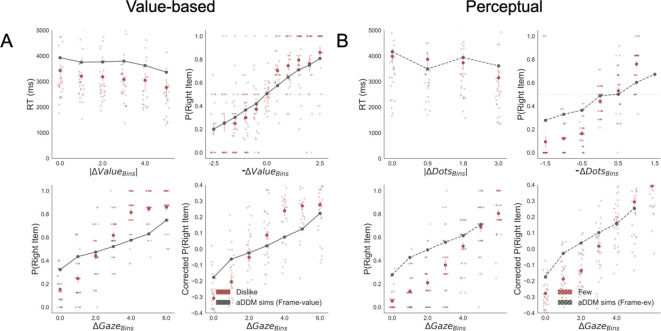
Replication of behavioural effects by aDDM simulations for dislike (A) and fewest (B) frames.Importantly, these models were fitted using goal-relevant evidence. The four panels present four relevant behavioural relationships found in the data. Top left: faster responses (shorter reaction time, RT) when the choice is easier (i.e. easier choices are found with higher |ΔValue| and |ΔDots| in Value and Perceptual Experiments, respectively). Top right: probability of choosing the right alternative increases when the evidence towards the left item is higher (-ΔValue and –ΔDots, that is, increment when left item is more valuable or has more dots than the right item). Bottom left: the probability of choosing the item on the right side of the screen depends on the gaze time difference (ΔGaze, calculated as the time observing the right minus the left item). Bottom right: gaze influence on choice depending on the difference in ΔGaze (check Results section for more details on gaze influence). Solid red dots depict the mean of the data across participants in dislike and fewest frames. Light red dots show the mean value for each participant. In Value Experiment, the solid grey lines show the average for model simulations. In the Perceptual Experiment, segmented grey lines show the average for model simulations. Data and simulations were binned for visualisation.